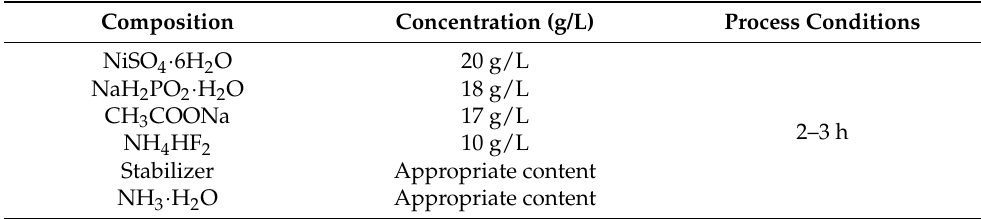
Table 2. Bath compositions and process parameters in the electroless plating